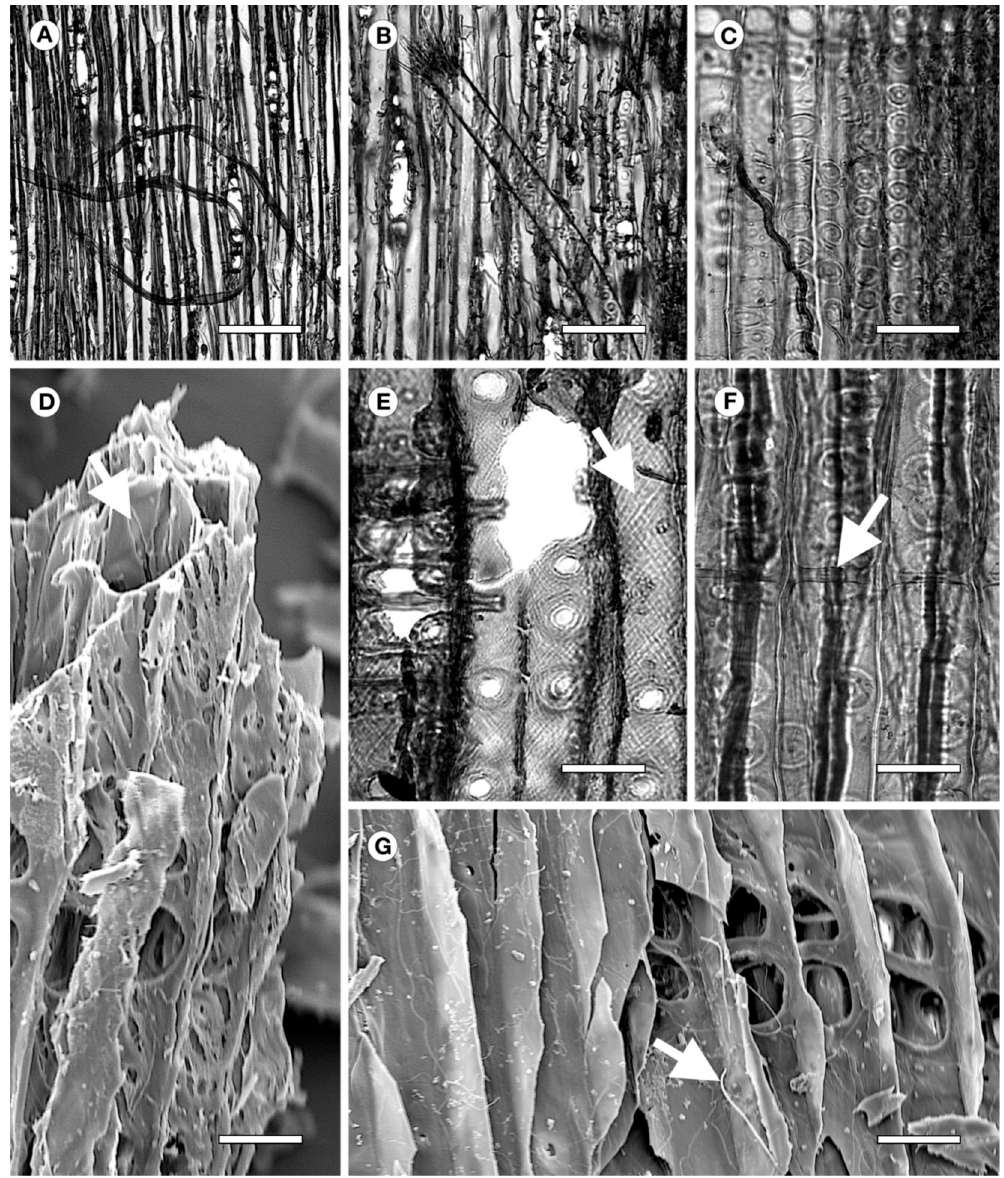
Figure 2. A , B , C , G , Fungi hyphae. D , Chains of cavities inside secondary wall due to soft-rot, E , Figure 2. ( A – C , G ) Fungi hyphae. ( D ) Chains of cavities inside secondary wall due to soft-rot, ( E ) Advanced state of deterioration of cell wall, F , Trabecula inside axial tracheids, G , Hyphae. Scale Advanced state of deterioration of cell wall, ( F ) Trabecula inside axial tracheids, ( G ) Hyphae. Scale bars—A, 350 μ m; B, 200 μ m; C, 100 μ m; D, E, F, G, 50 μ m. bars—A, 350 µ m; B, 200 µ m; C, 100 µ m; D, E, F, G, 50 µ